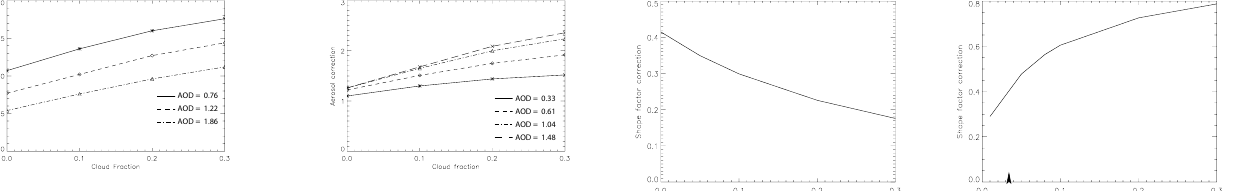
Figure 5. Aerosol correction factor sensitivity to cloud fraction for different AODs. Left: case with an elevated aerosol layer. Right: case with a surface-only aerosol layer. Different AODs were ob- tained by rescaling either the elevated aerosol layer (left panel) or the surface aerosol layer (right panel).